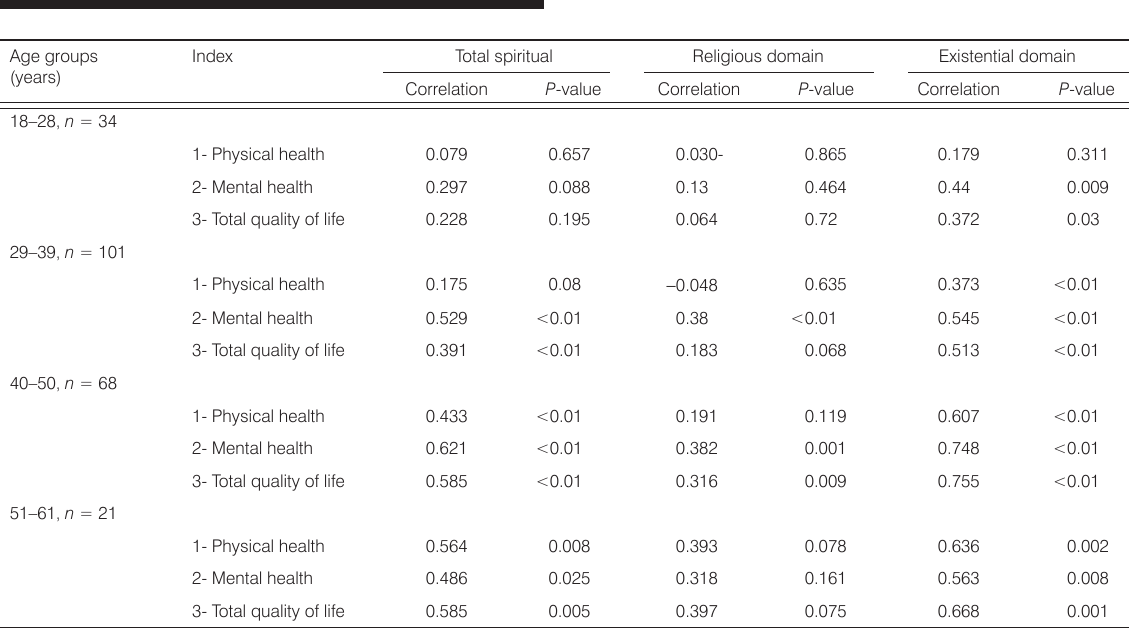
Table 2. The relationship between spiritual well-being and QoL dimension according to age